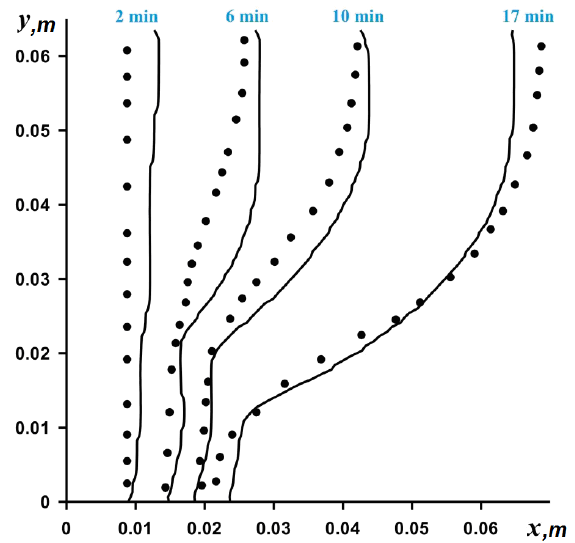
Figure 2. Comparison of obtained numerical data (solid line) and experimental data (dots) [29].